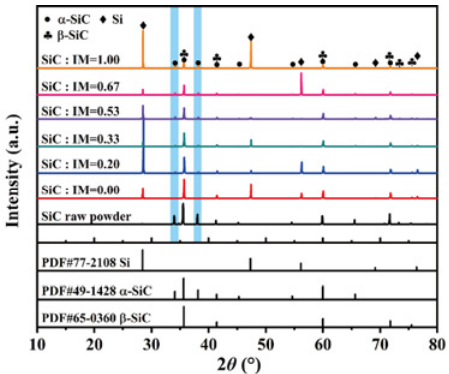
Fig. 11 XRD patterns of SiC composites.